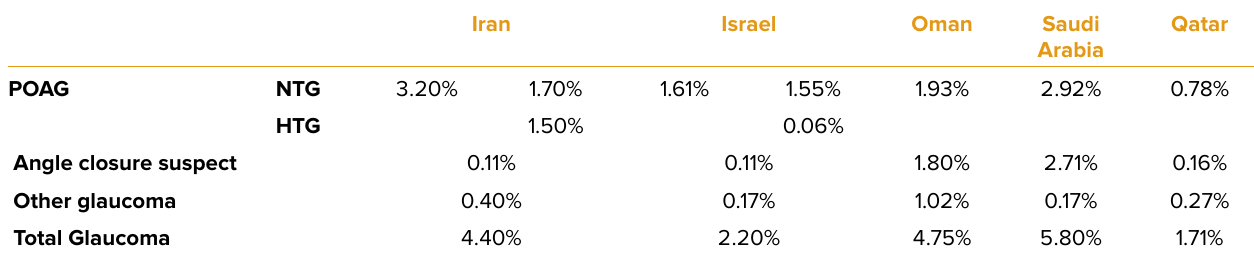
Cup-to-Disc ratio (C/D) African descent 0.35 European descent 0.24 Korea 0.34 +/– 0.12 China 0.44 +/– 0.17 Singapore 0.40 +/–